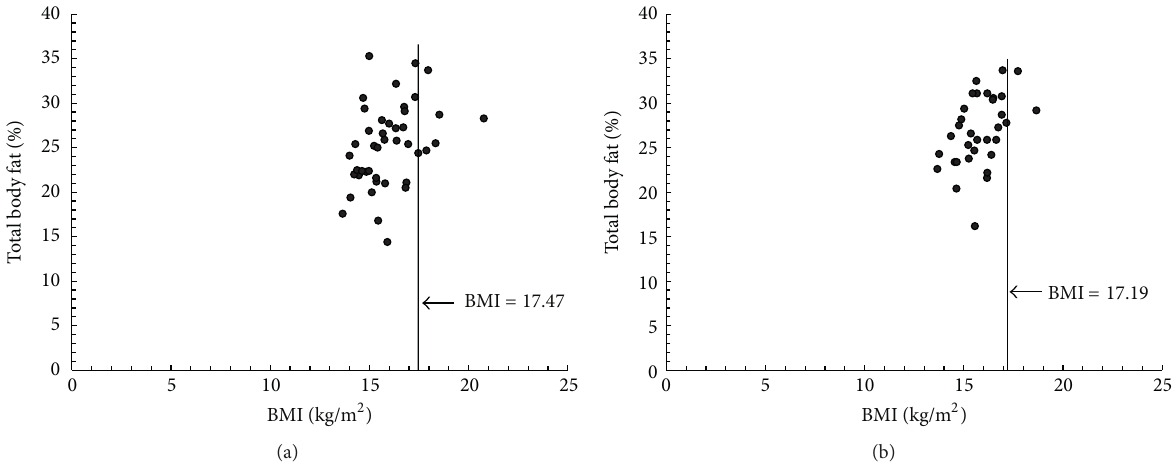
Figure 1: Body mass index (BMI) (kg/m 2 ) (𝑥) versus total body fat (%) (𝑦) in healthy Swedish 4-year-olds in relation to the age- and sex- specific cut-offs for overweight [6], (a) boys ( 𝑛 = 43 ) with overweight cut-off 17.47, (b) girls ( 𝑛 = 33 ) with overweight cut-off